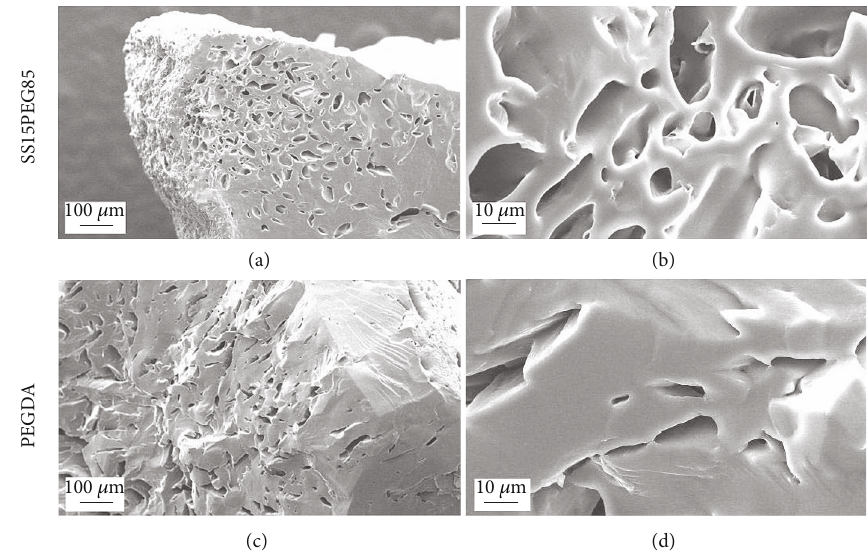
Figure 3: SEM images showing cross-sectional morphology of the freeze-dried hydrogels; SS15PEG85 (a, b) and PEGDA (c, d).